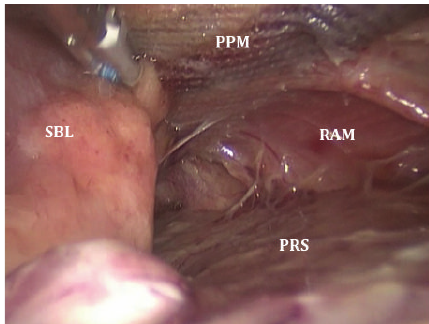
Figure 2: Laparoscopic view of the interstitial hernia. Small bowel loop (SBL) inside the interstitial space between polypropylene mesh (PPM) and rectus abdominis muscle (RAM) above and posterior rectus sheath (PRS) below.